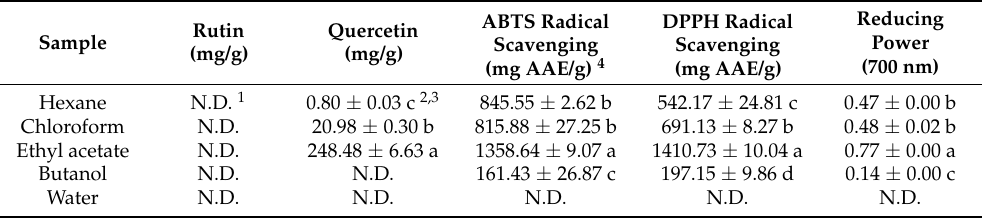
Table 2. ABTS and DPPH radical scavenging activity and reducing power of solvent fraction for rutin treated by 300 ◦ C and 100 bar.